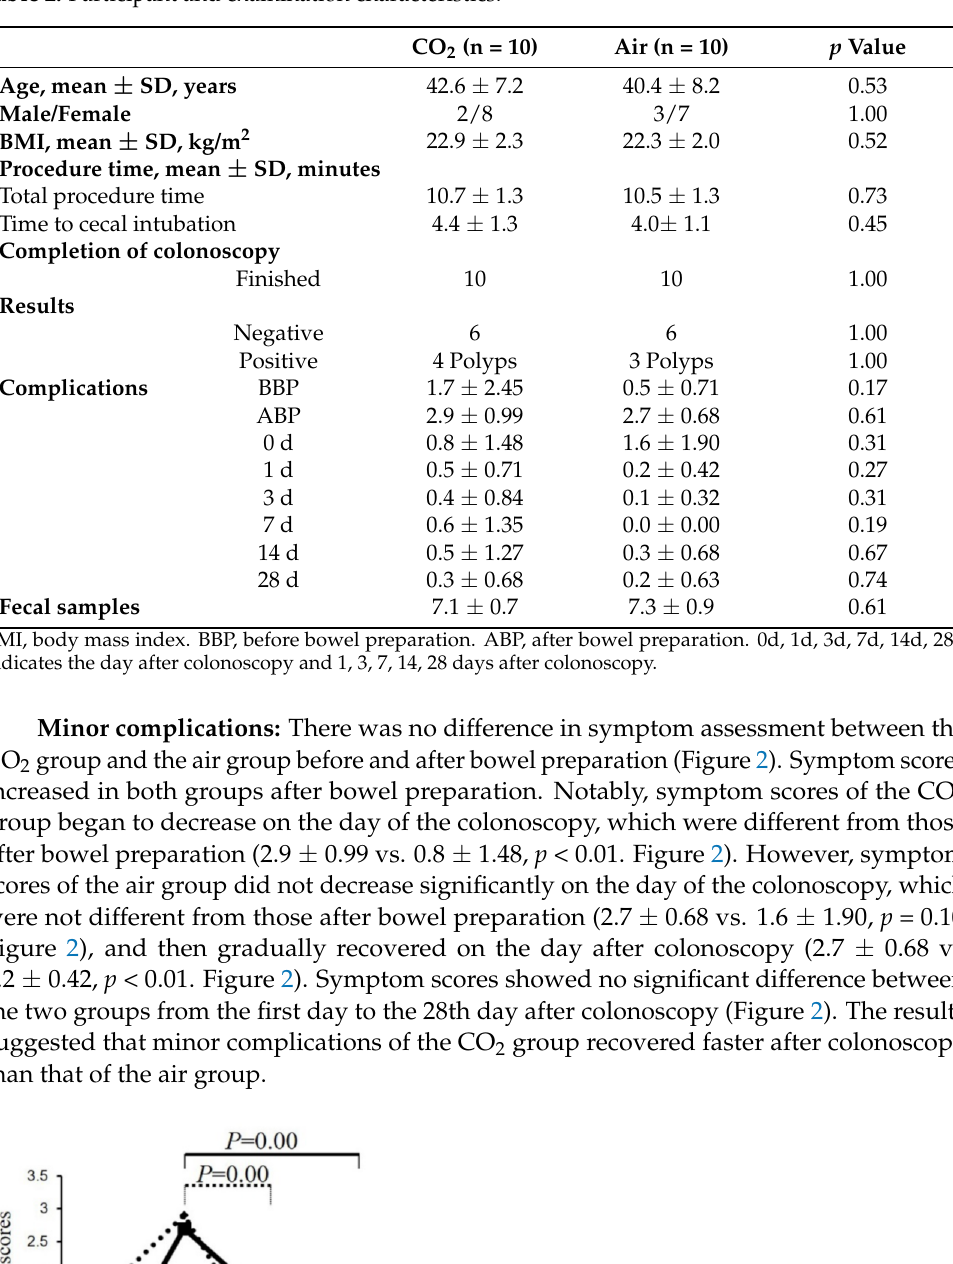
Table 2. Participant and examination characteristics.